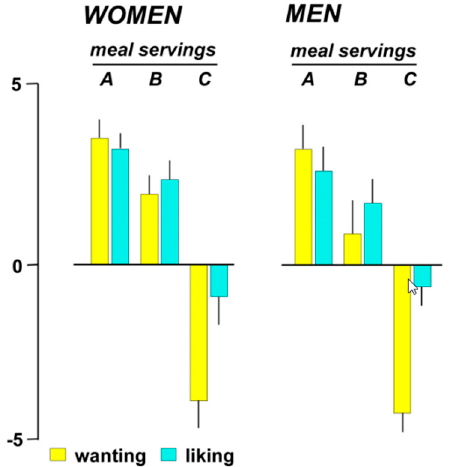
Figure 3. Meal-wanting and liking during meal ingestion. Data correspond to: ( A ) the first meal serving, ( B ) the serving that induced maximal well-being, and ( C ) the serving that induced full satiation (last serving).